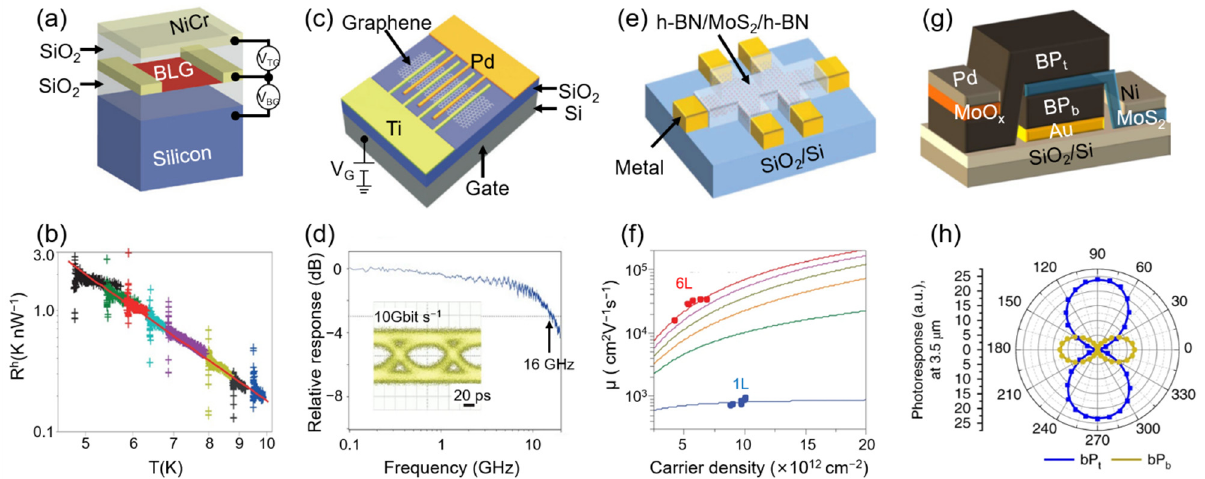
Figure 6. 2D material-based photodetectors. ( a ) Device structure of a dual-gated bilayer graphene bolometer. Reproduced with permission from F. H. L. Koppens et al., Nature nanotechnology; pub- lished by Springer Nature, 2014 [26]. V TG , top gate bias; V BG , back gate bias. ( b ) Temperature de- pendence of heat resistance. Reproduced with permission from Jun Yan et al., Nature nanotechnol- ogy; published by Springer Nature, 2012 [103]. ( c ) Metal–graphene–metal (MGM) PDs with asym- metric metal contacts, and ( d ) Relative photoresponse versus light intensity modulation frequency. Reproduced with permission from Thomas Mueller et al., Nature Photonics; published by Springer Nature, 2010 [104]. Inset: receiver eye diagram obtained using this MGM photodetector, showing a completely open eye. Scale bar, 20 ps. ( e ) Schematic of the hBN-encapsulated MoS 2 multiterminal device, and ( f ) The carrier density dependence of Hall mobility from 1 L and 6 L MoS 2 . Reproduced with permission from Xu Cui et al., Nature nanotechnology; published by Springer Nature, 2015 [105]. ( g ) Schematic of polarization-resolved BP/MoS 2 heterojunction photodiode, and ( h ) Measured photoresponse under linearly polarized illumination at λ = 3 μ m in BP t and BP b as a function of polarizer angle. Reproduced with permission from James Bullock et al., Nature Photonics; pub- lished by Springer Nature, 2018 [106].